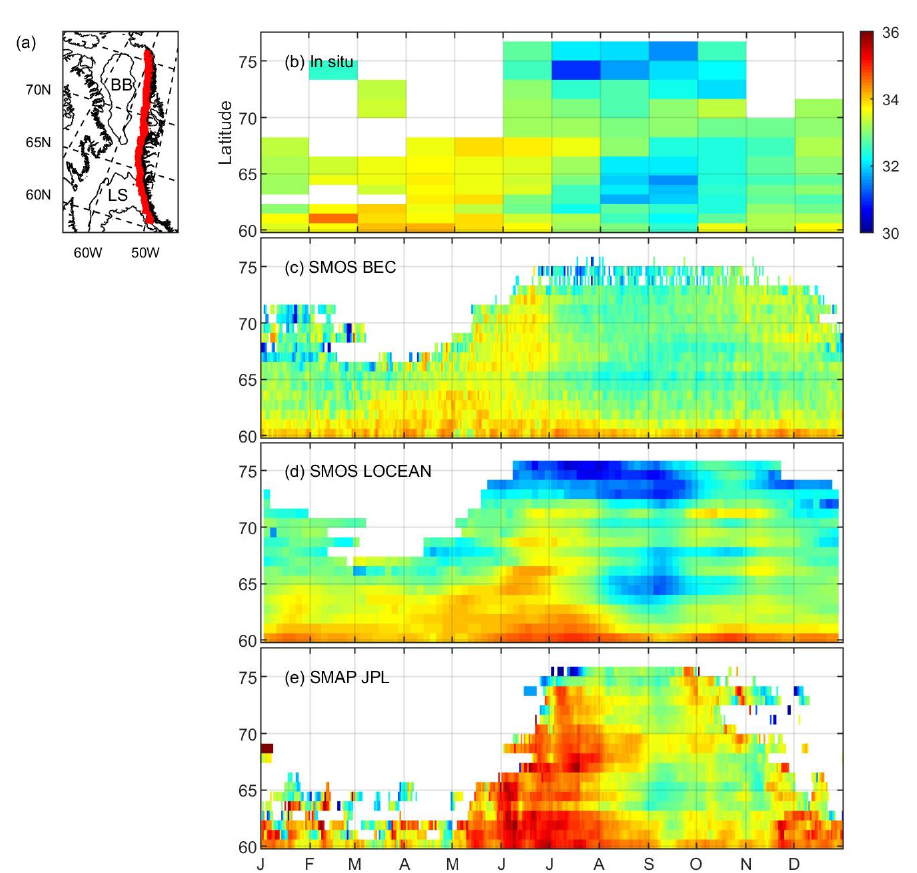
Figure 2. ( a ) Study area. BB: Baffin Bay; LS: Labrador Sea. Hovmöller diagram (month vs. latitude) of surface salinity averaged within 60 km from the west Greenland coast (area shown in red in panel) ( a ) based on ( b ) in situ data, ( c ) SMOS BEC, ( d ) SMOS LOCEAN, and ( e ) SMAP JPL.